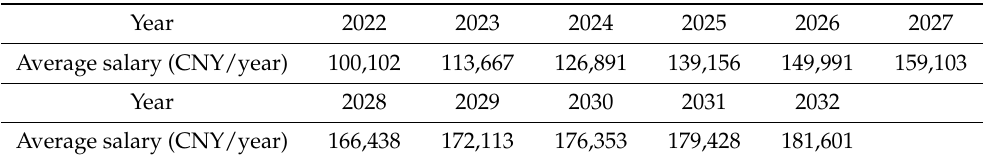
Table 6. Average wage forecast for Anhui Province from 2022 to 2032. Year 2022